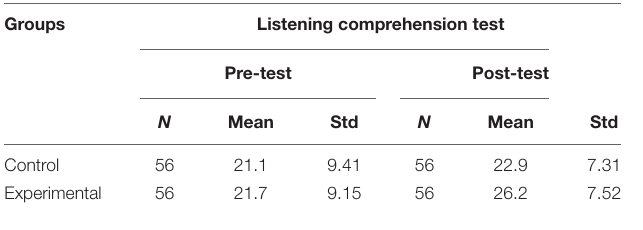
TABLE 6 | Descriptive statistics of the pre- and post-tests. Groups